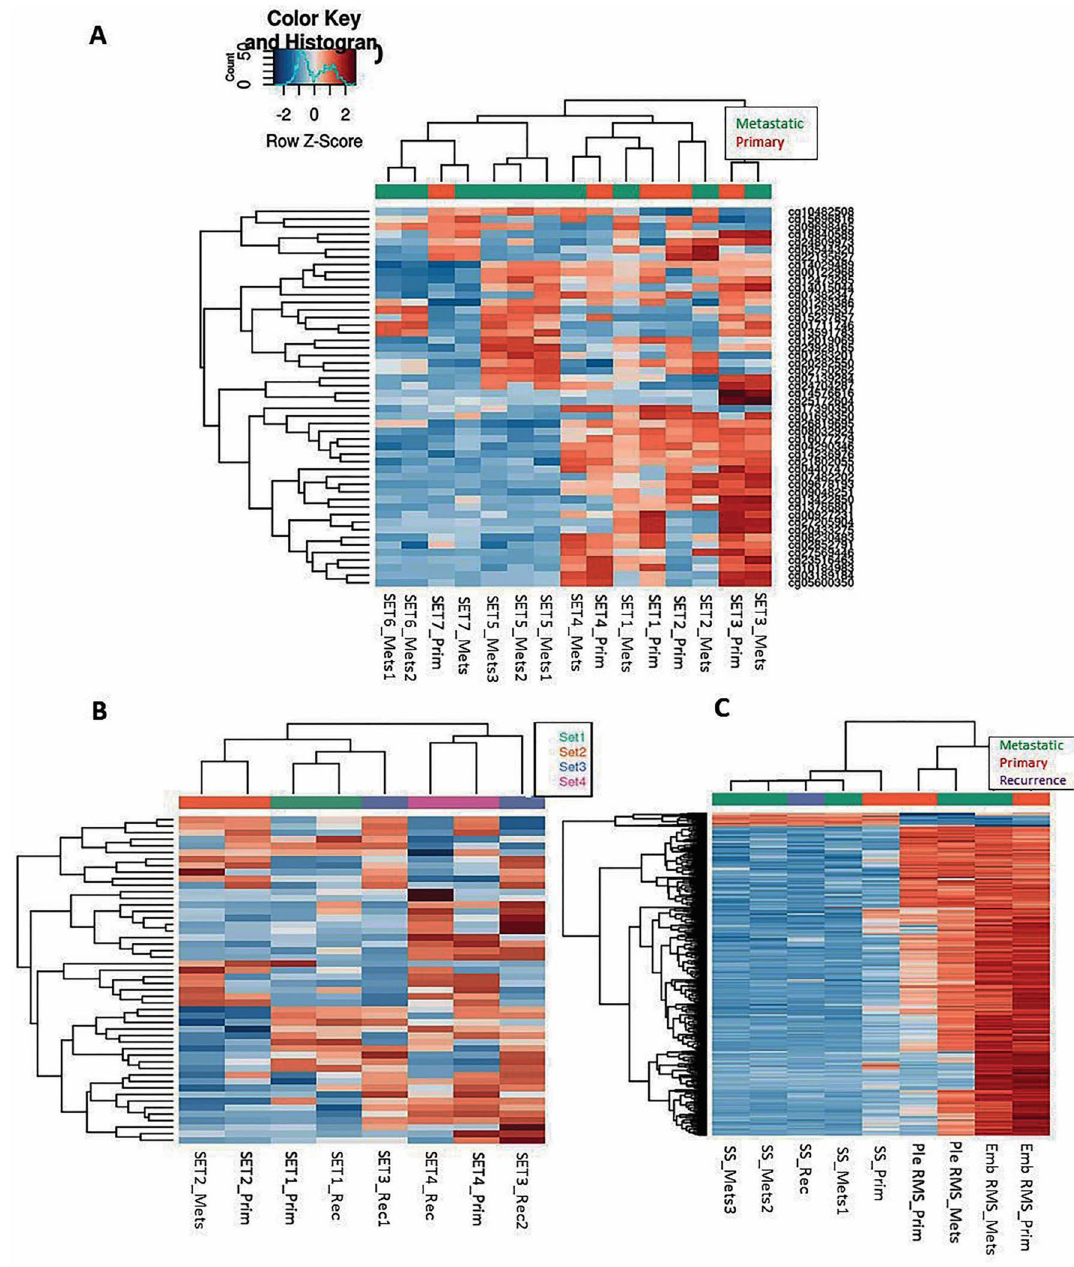
Figure 1. Heatmaps of the top 50 most variable probes across the samples using hierarchical clustering to visualise sample similarity and clustered probes generated according to tumour type: Leiomyosarcomas ( A ), Myxofibrosarcomas ( B ) and synovial sarcoma (SS) and Embryonal (Emb) and Pleomorphic (Ple) rhabdomyosarcomas (RMS; C ). Red and blue represents hypermethylation and hypomethylation, respectively. Clustering heat maps created using M values. Illumina Infinium MethylationEPIC BeadChip and R statistical environment